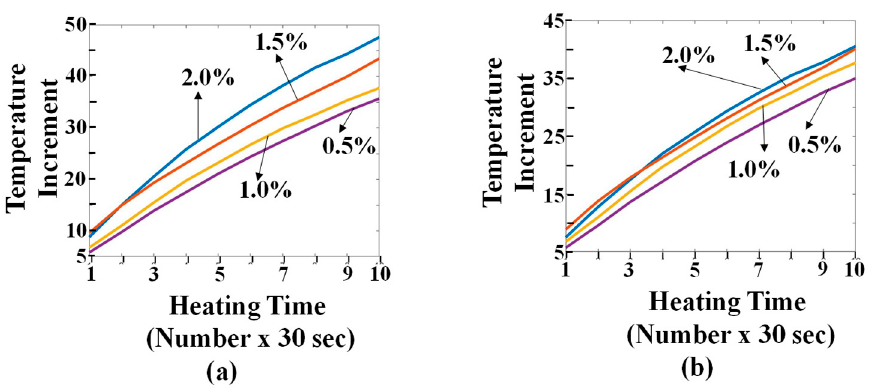
Figure 10. Comparisons of the surfaces’ average temperature increments of four different percentage prisms: ( a ) Directly measured, ( b ) Compensated.